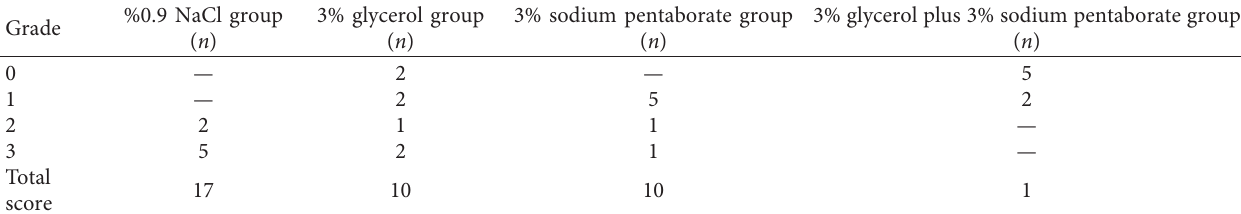
Table 5: Grades of histopathologic fibrosis.